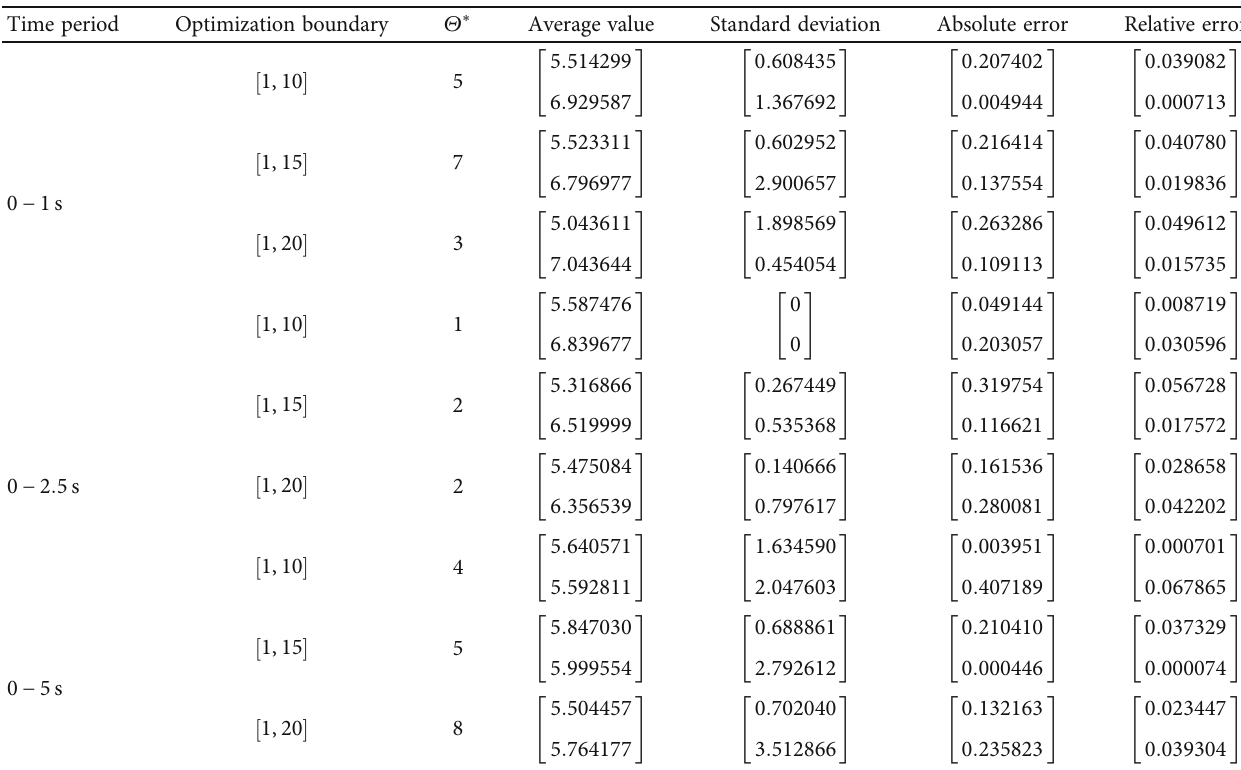
Table 3: Identi fi cation results of the pulsating wind velocity component. Time period